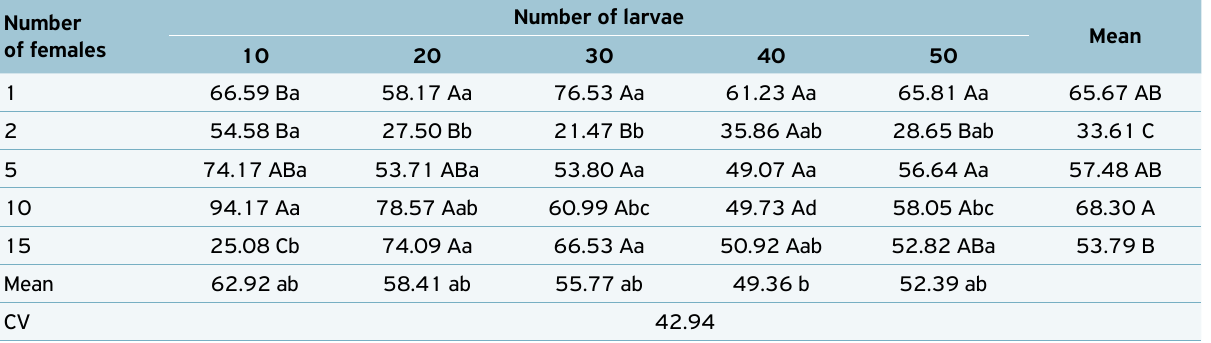
1 Different letters mean significance between the means, in the lines (lower case) and columns (upper case) (p<0.05); CV: coefficient of variation. Table 2. Parasitism rates (%) of Diachasmimorpha longicaudata in Ceratitis capitata larvae. Number of females